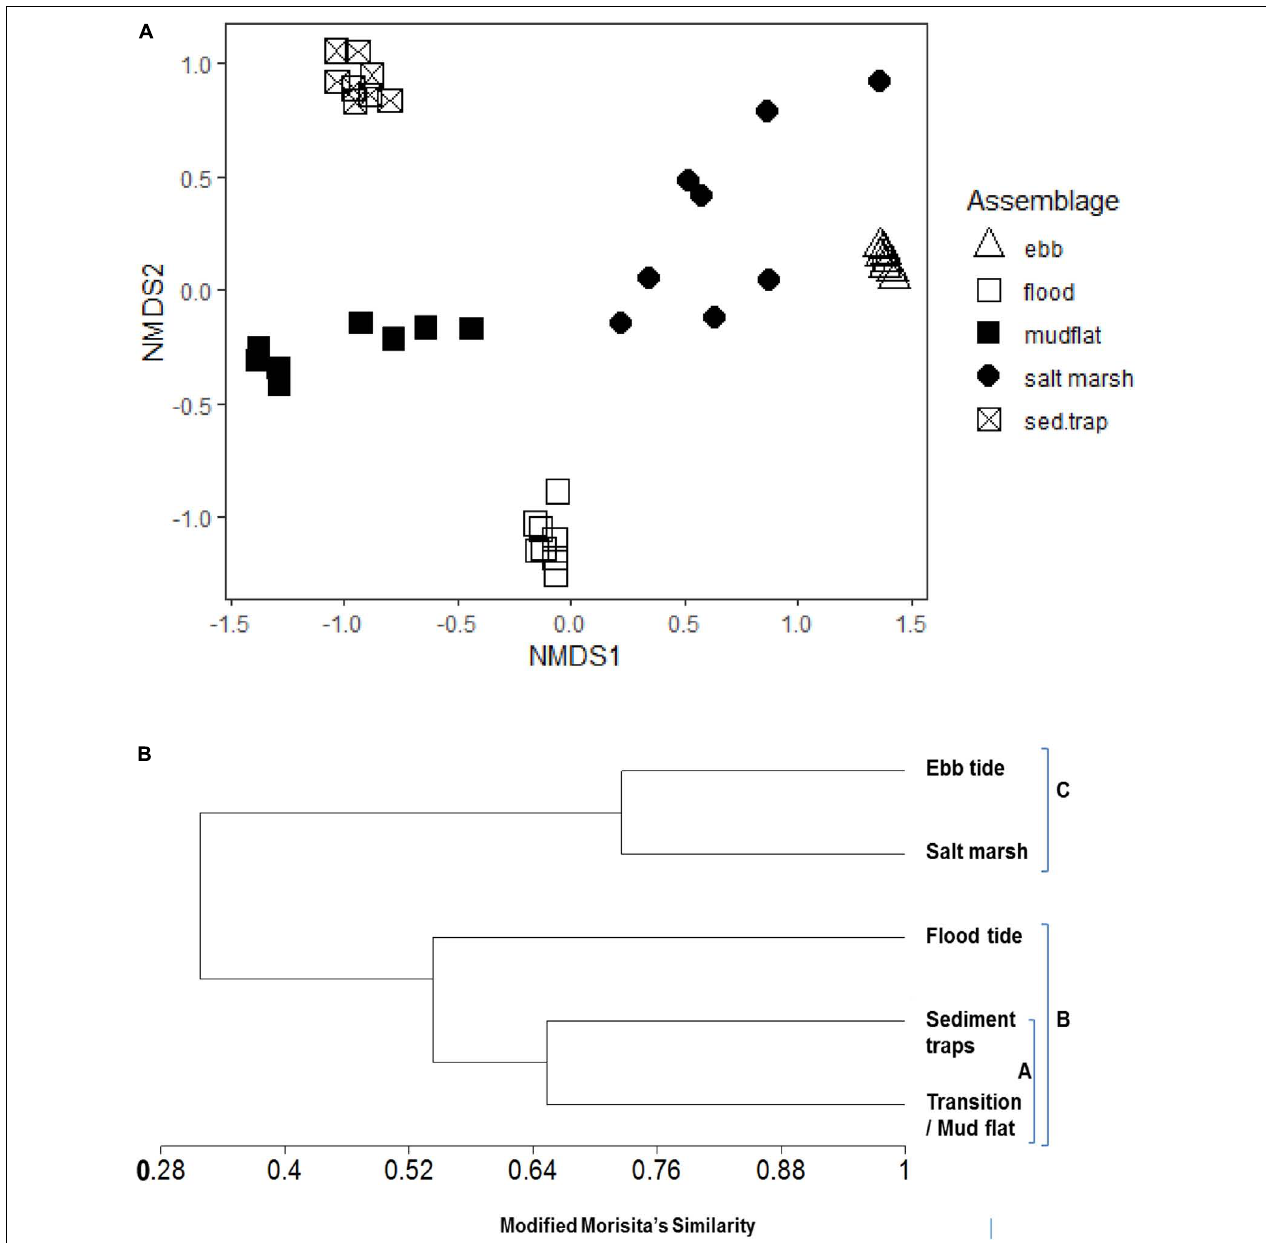
FIGURE 7 | (A) NMDS plot of species composition of diatom assemblages (relative abundance) sampled from ebb-tide water, salt marsh sediment surface, flood-tide water, sediment traps (deployed on transition zone of the mudflat), and transition zone of the mudflat sediment surface samples. (B) Dendrogram showing% similarity (Modified Morista’s) in MPB diatom species composition for the five assemblage